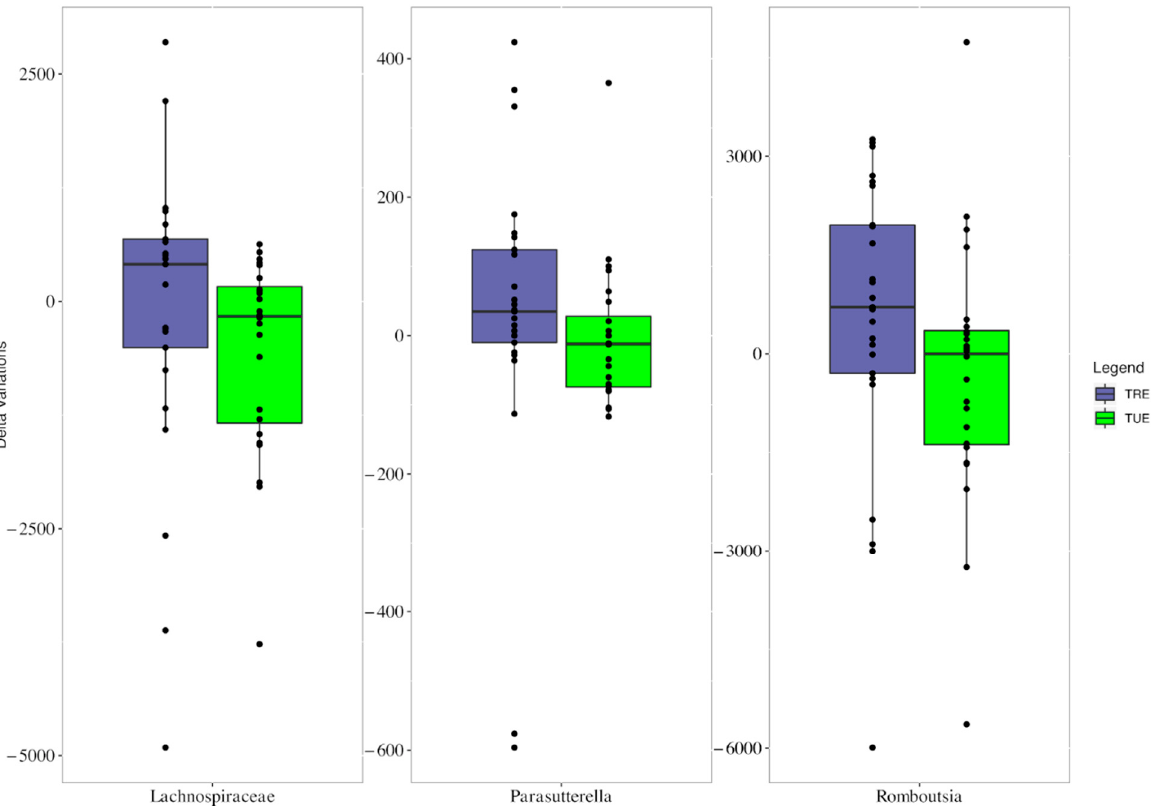
Figure 3. Boxplots showing the mean changes (study end values minus enrollment values) of Lach- nospiraceae, Parasutterella, and Romboutsia in TRE (very pery bars) and TUE groups (green